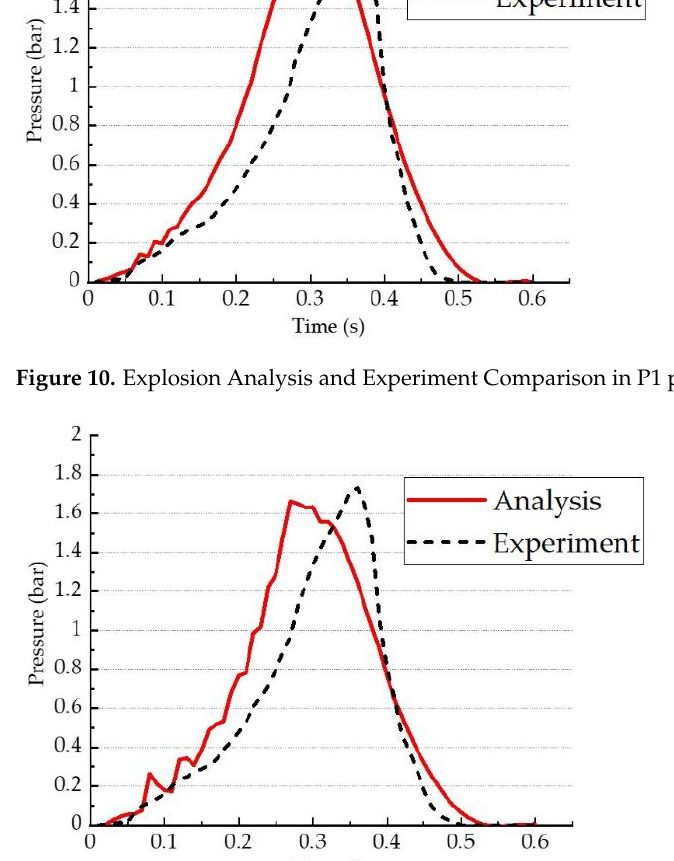
Figure 11. Explosion Analysis and Experiment Comparison in P2 point.